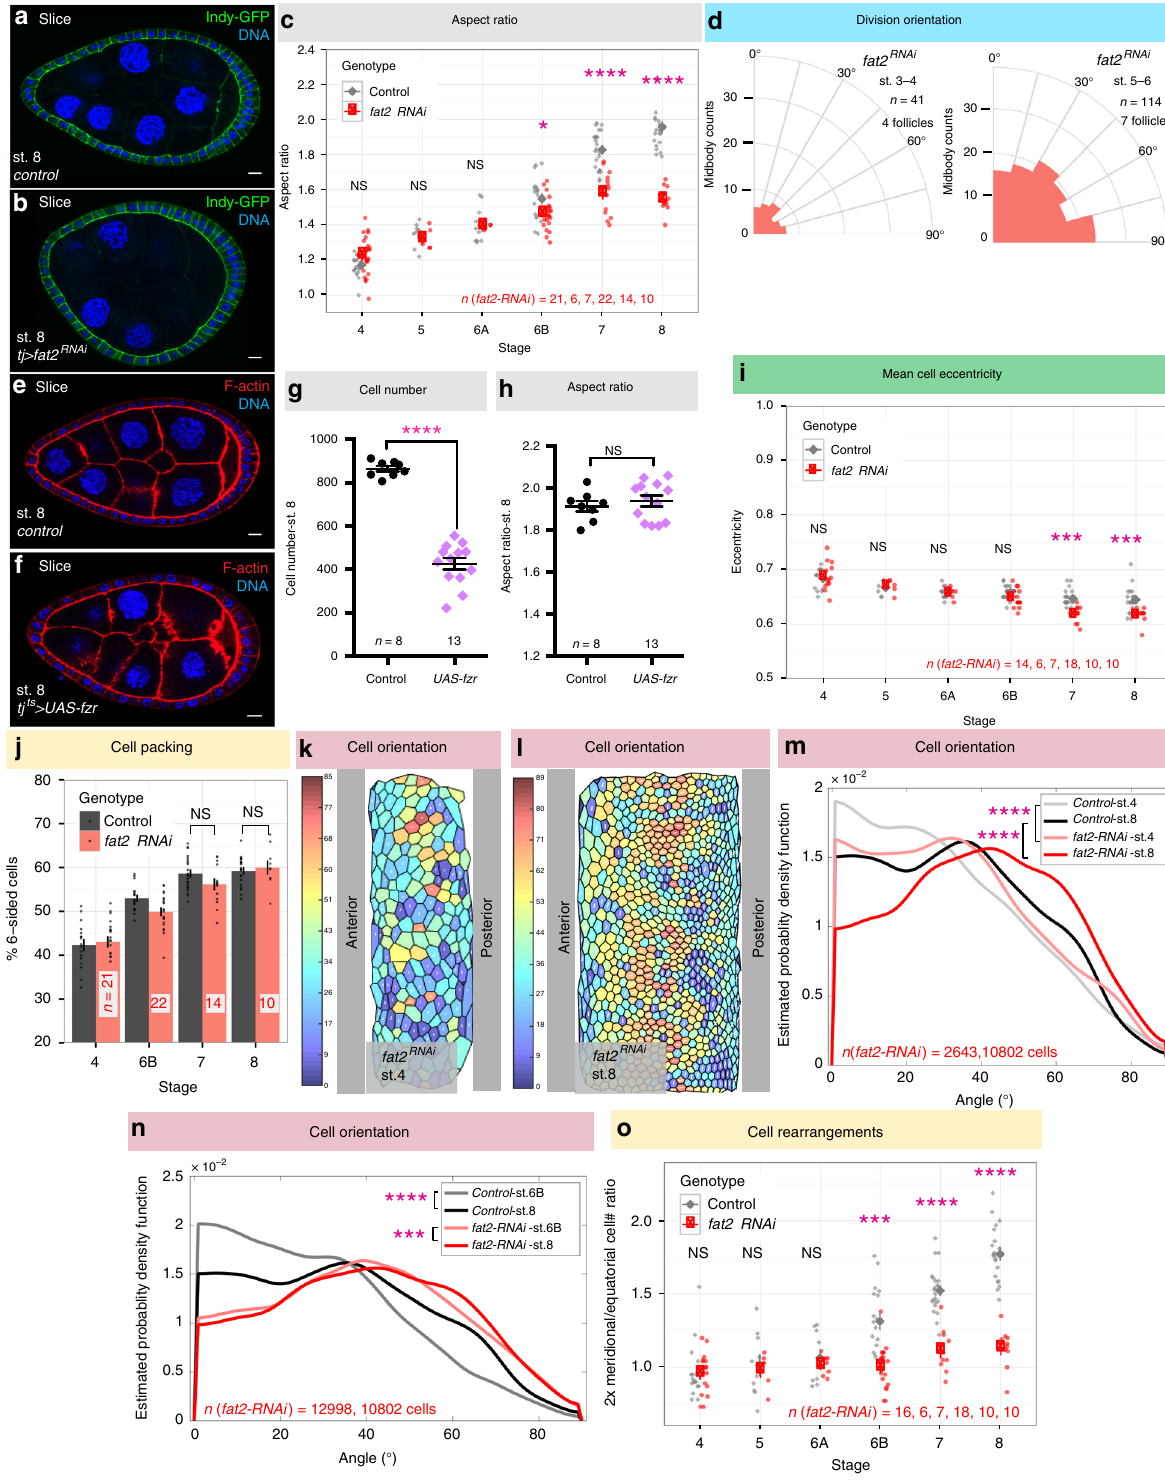
Control -st.6B Control -st.8 fat2-RNAi -st.6B